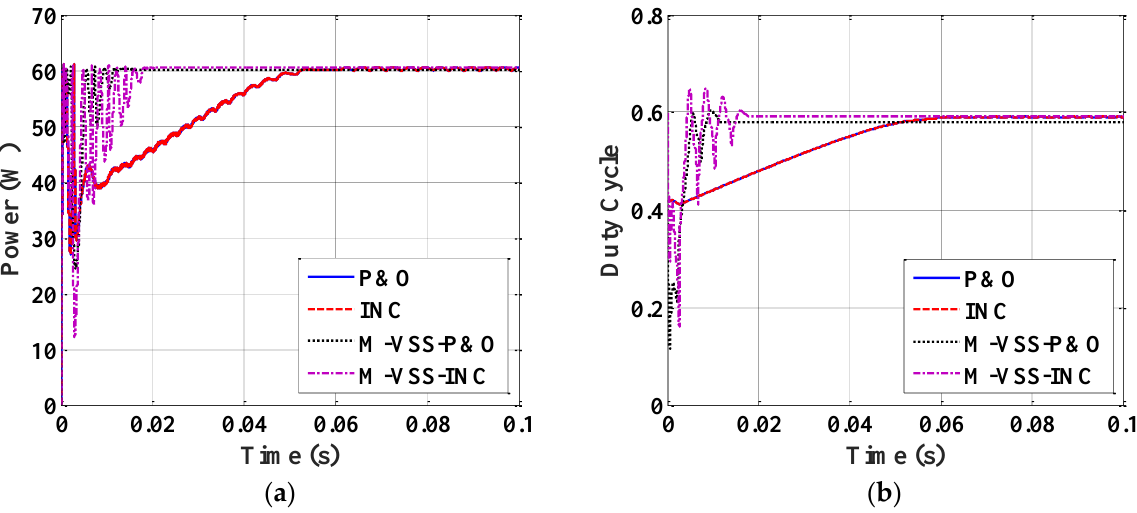
Figure 6. STC test of MSX60 solar cell performance: ( a ) Output power and ( b ) duty cycle variation.